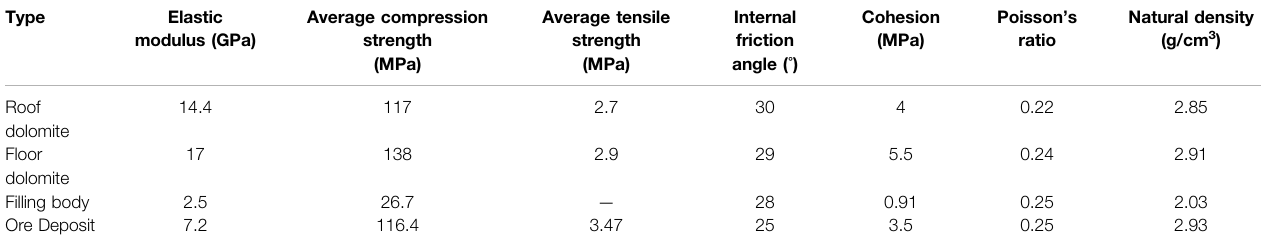
TABLE 1 | Physical and mechanical parameters of rock mass in ore